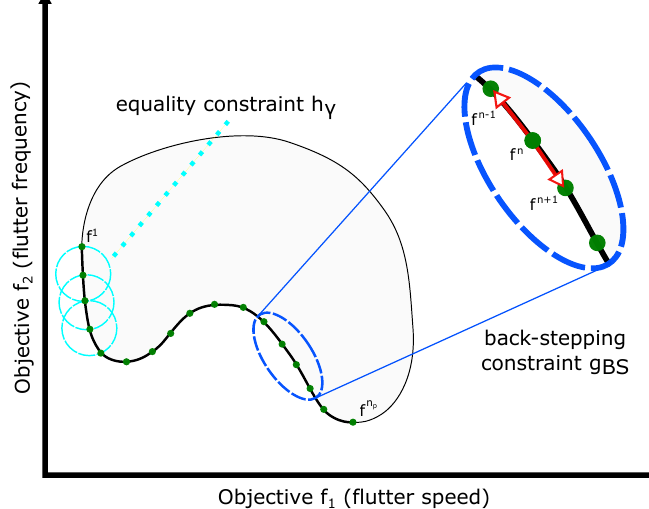
Figure 5. Illustration of the constraints